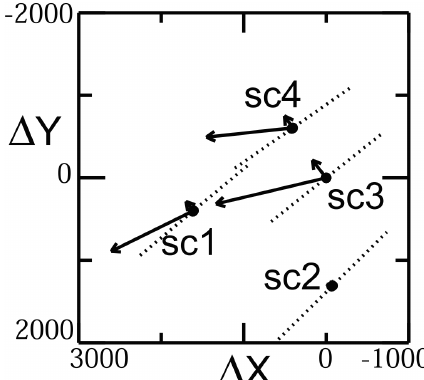
Fig. 8. Dipolarisation fronts observed by four Cluster spacecraft on 22 July 2001 in XY GSM system with reference to C3 position (from Nakamura et al., 2002). Dipolarisation fronts are shown by dotted lines, The long arrow shows the plasma flow during the interval of maximum flow and the short arrow the flow during the dipolarisation projected perpendicular to the dipolarisation front.